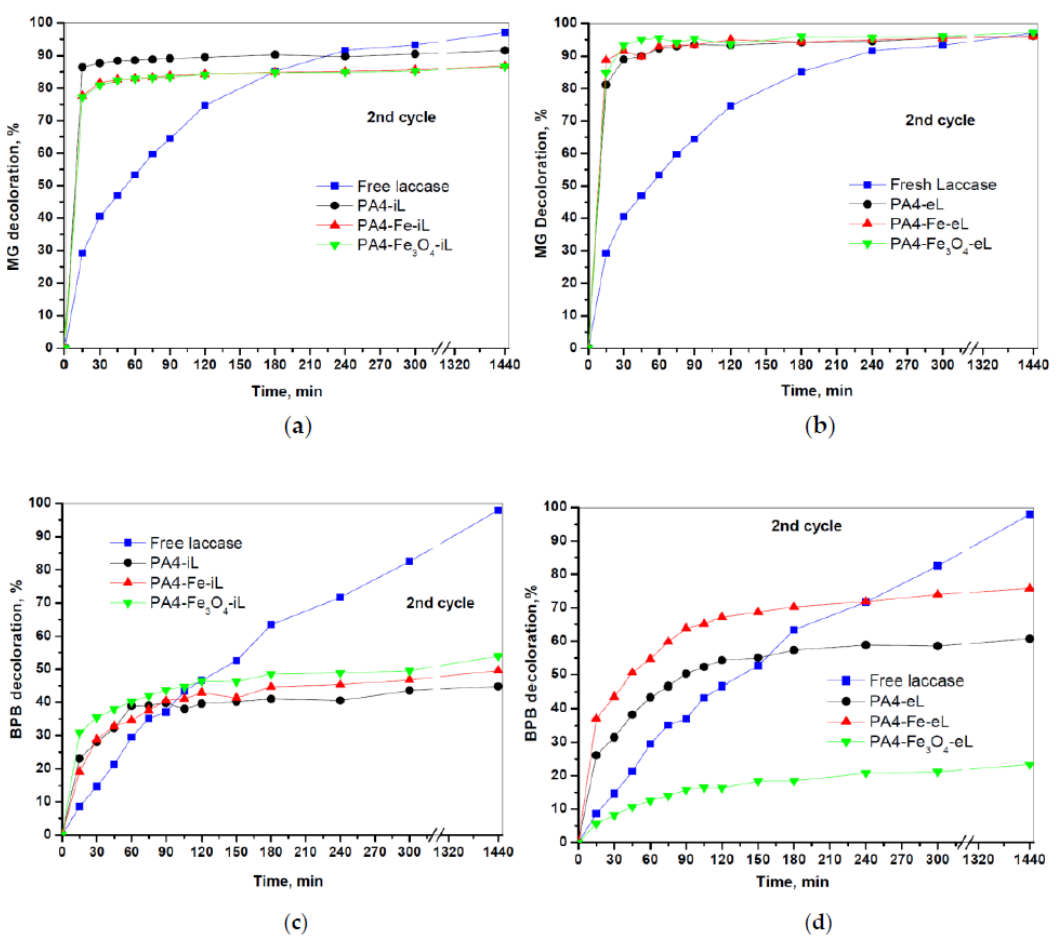
Figure 14. Second cycle of decolorization of: ( a , b )—malachite green (MG) and ( c , d )—bromophenol blue (BPB) by PA4@iL and PA4@eL samples. The decolorization percentage was calculated according to Equation (5) (see Materials and Methods, Section 3.3.5.).